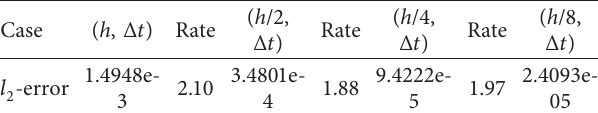
Table 10: Convergence test results of the unconditionally stable method for space